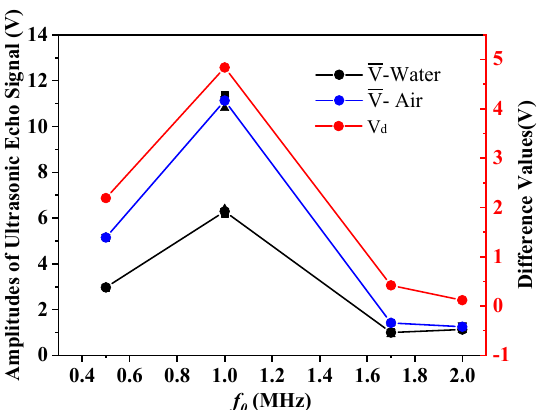
Figure 5. Results comparison diagram with different frequencies.